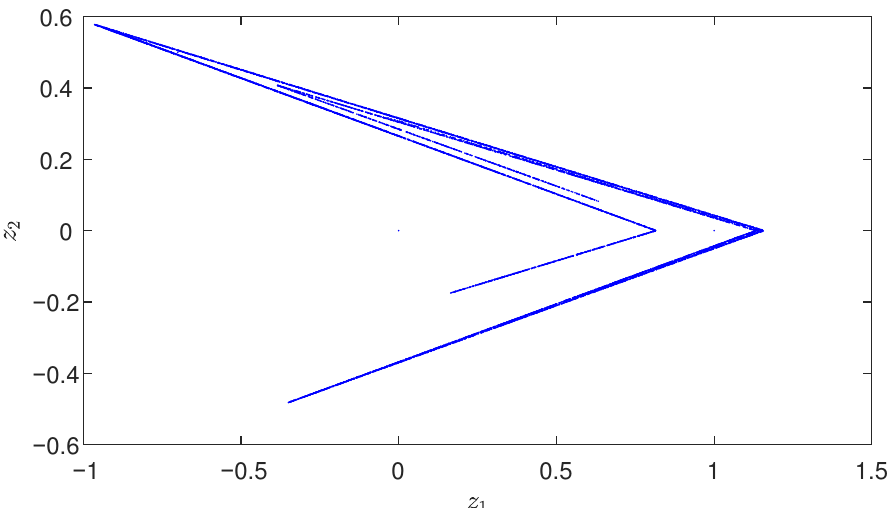
Figure 5. Lozi chaotic map with a = 1.7, b = 0.5, z 1 ( 0 ) = 0, and z 2 ( 0 ) = 0 after 10,000